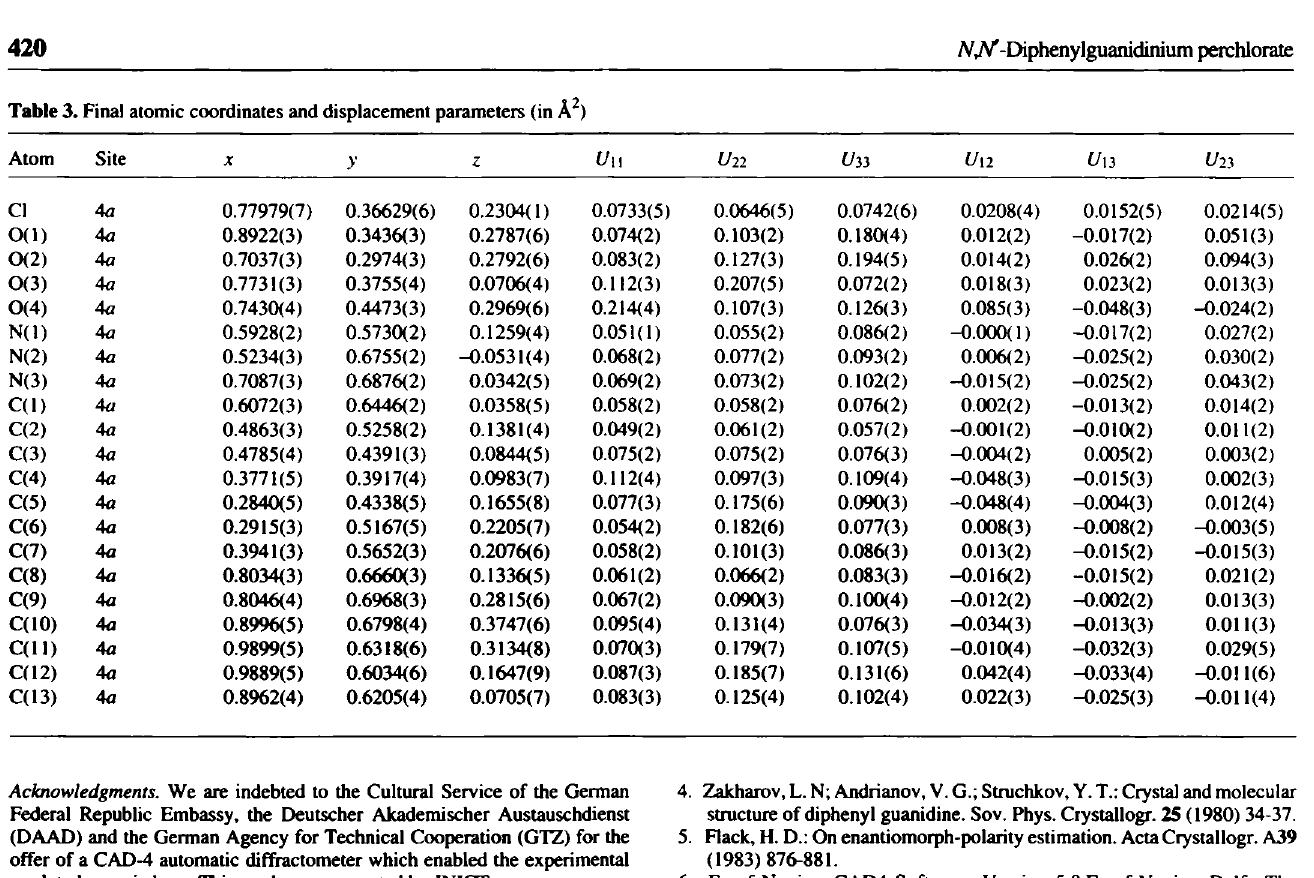
Table 3. Final atomic coordinates and displacement parameters (in Â^)